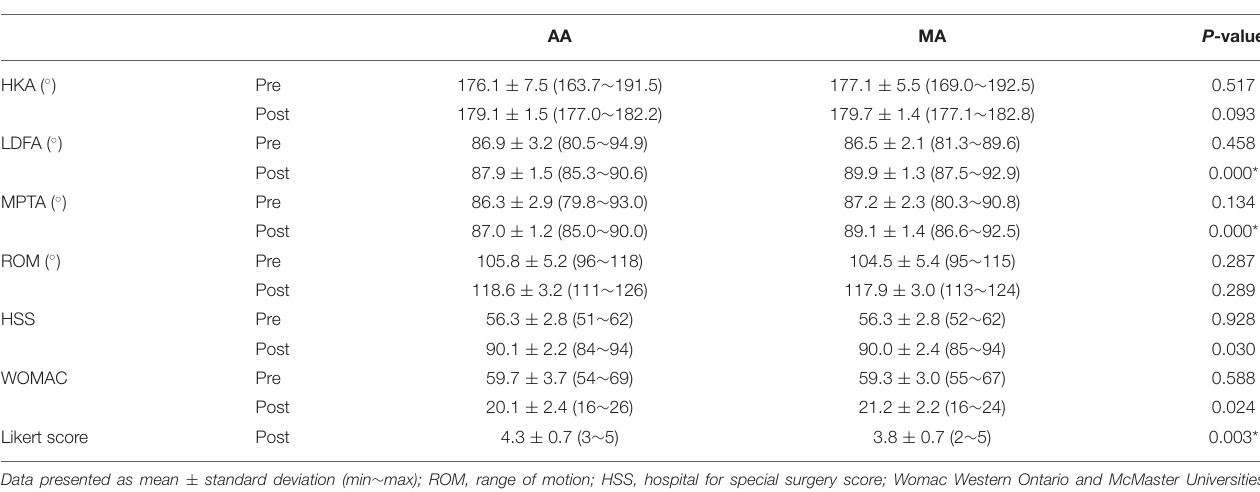
TABLE 3 | Perioperative radiological and clinical assessment.